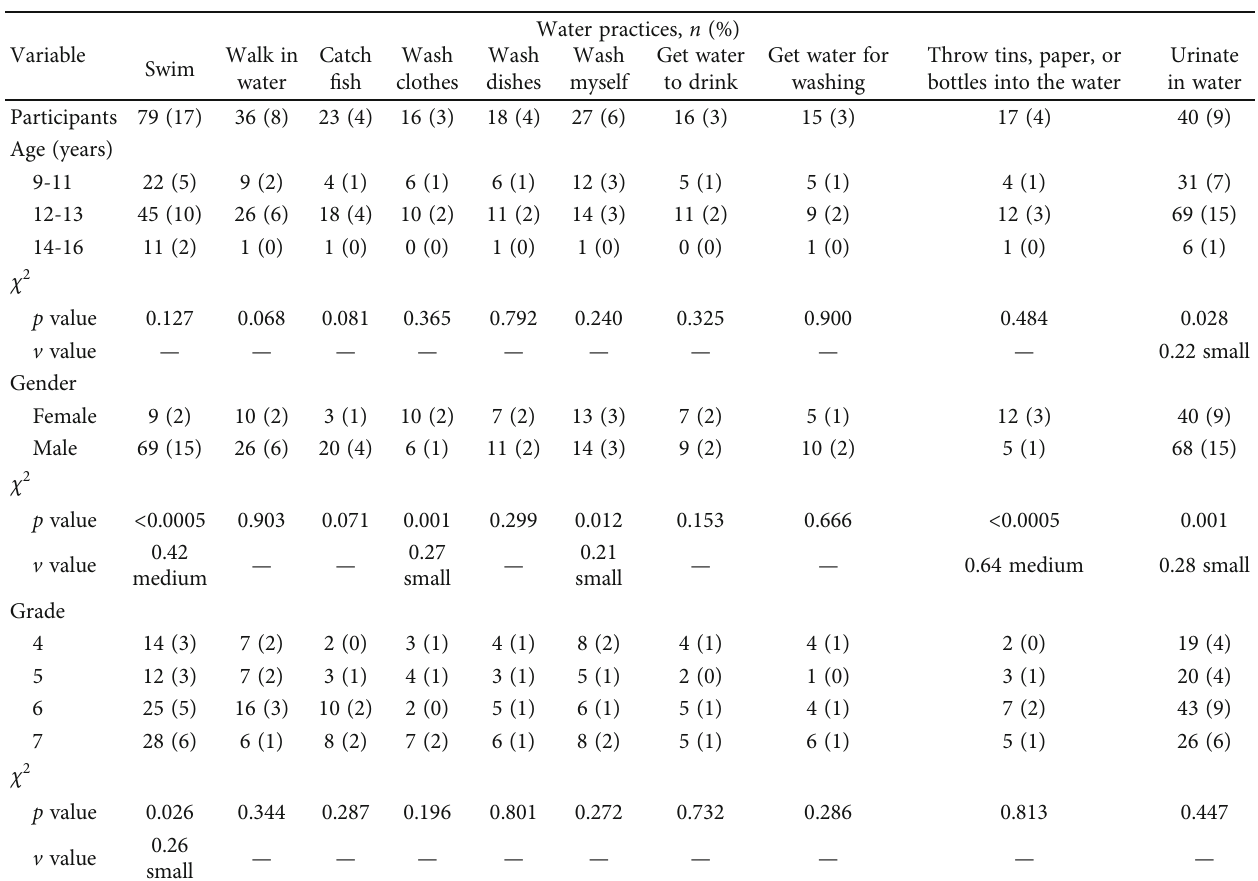
Table 4: Water practices among study participants ( n = 458 ).